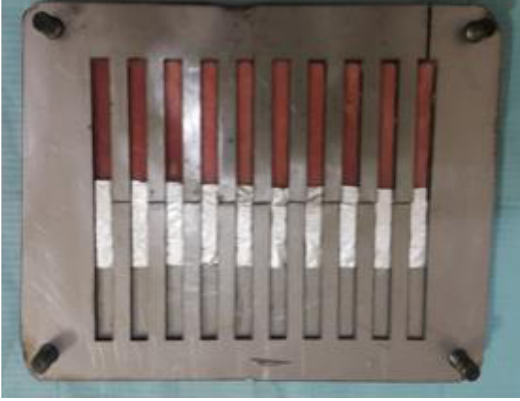
Figure 4: Application of tinfoil on acrylic specimens.